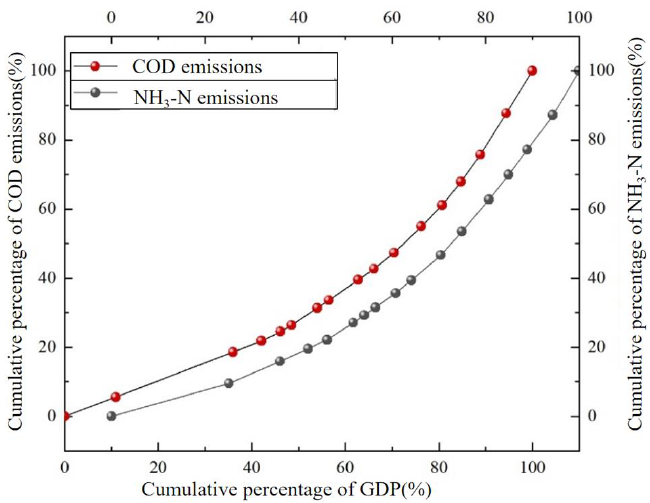
Figure 4. Lorenz curves of COD and NH 3 -N based on GDP indicators.